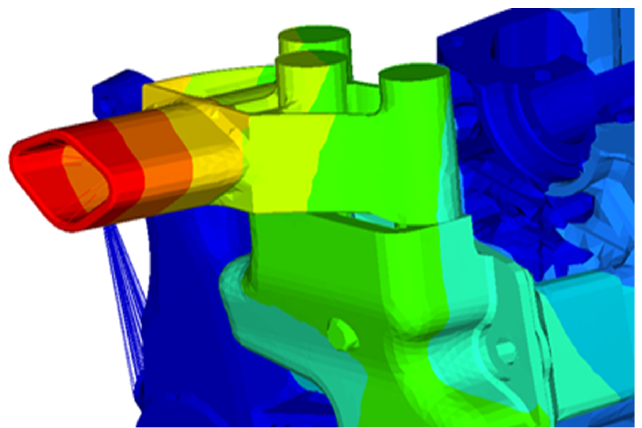
Figure 5. Eigenmode at nearly 2700 Hz (Figure 4) with highlight of engine bracket response.